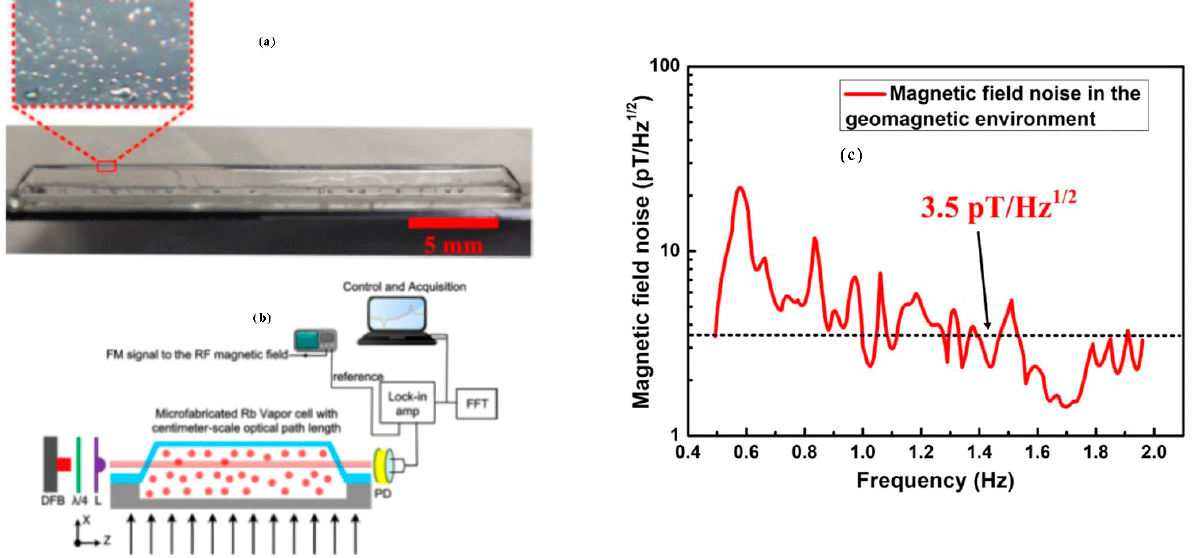
Figure 25. Pyramid-shaped micro-fabricated vapor cell (Southeastern University, 2020). ( a ) is the physical map of vapor cell, ( b ) is sensor structure diagram, ( c ) is the experimental data graph. Reprinted from Ref [112].